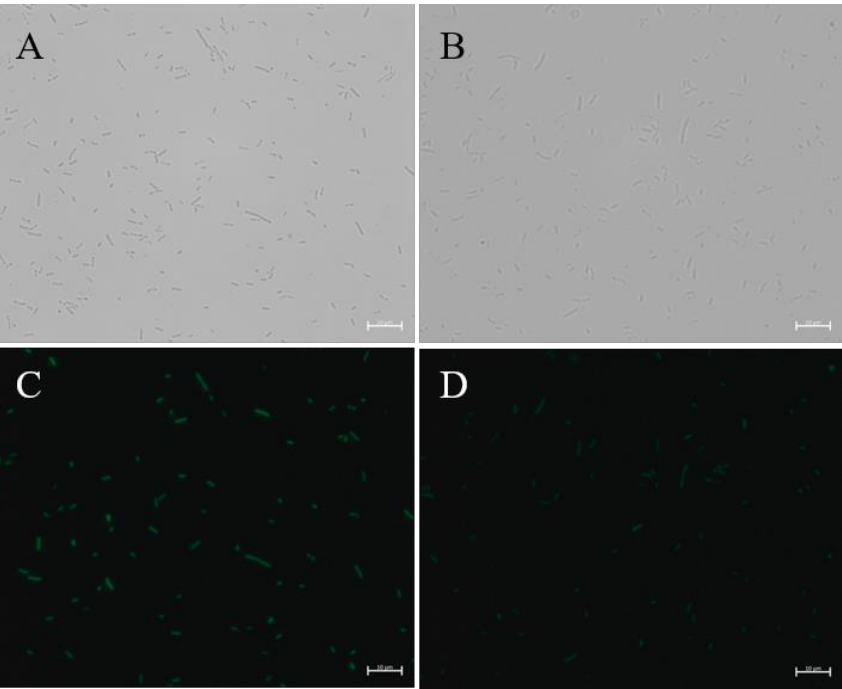
Figure 8. RNA synthesis in WT and Δ ygfY . Cultures at the early exponential phase were exposed to EU. Nascent RNA incorporated with EU was detected by azide-modified Alexa Fluor 488 under a microscope. ( A , C ) Shows cells of WT under brightfield and fluorescence. ( B , D ) Shows cells of Δ ygfY under brightfield and fluorescence. The experiments were repeated three times and similar results were observed.